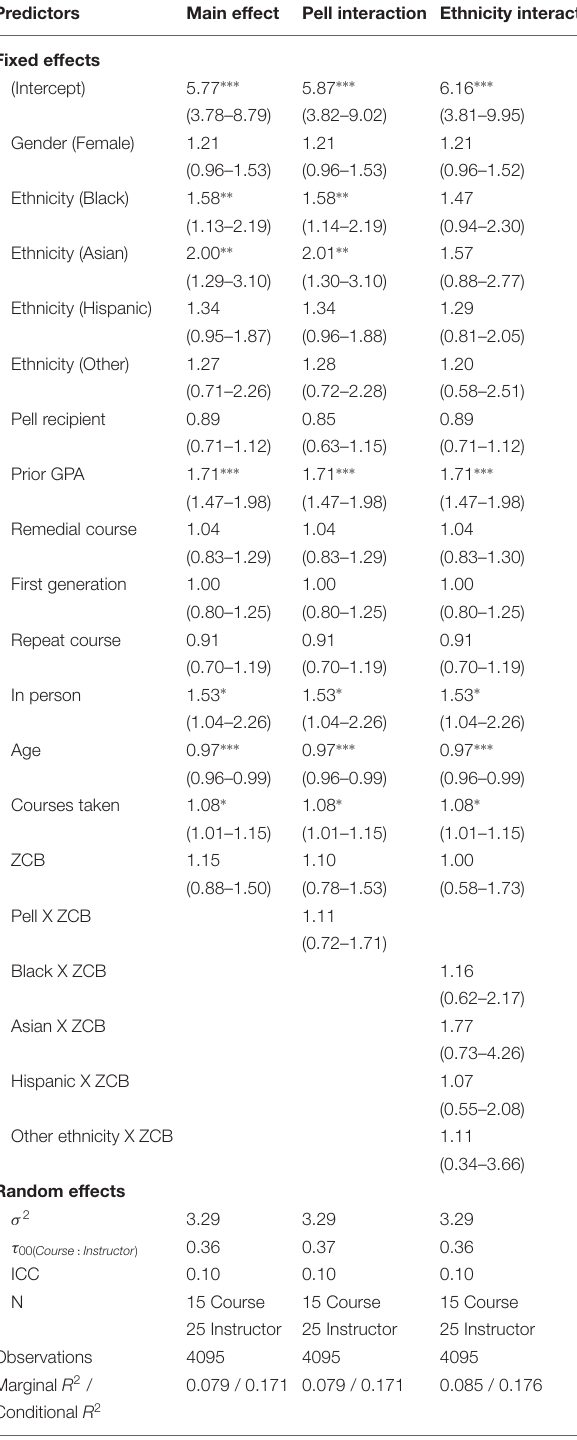
TABLE 2 | Regression results for predicting completing a course.